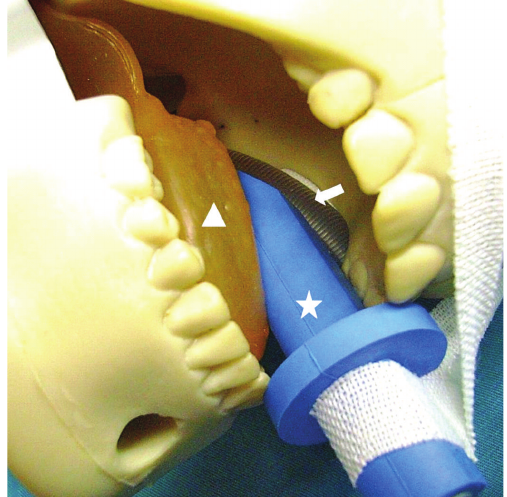
Figure 5: The photograph shows an intraoperative intraoral simulation model. The tongue (triangle) is injured by compression due to a bite block (star) and an intubation tube